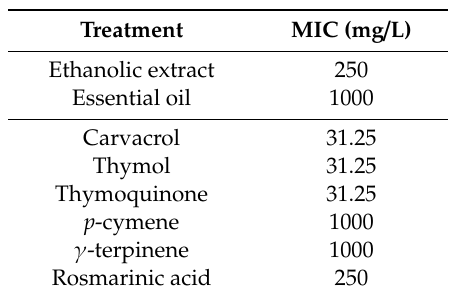
Table 1. Antimicrobial activity of Satureja montana ethanolic extract and essential oil, and of the six pure compounds against Campylobacter jejuni 11168, in terms of their minimal inhibitory concentrations (MICs) in mg /